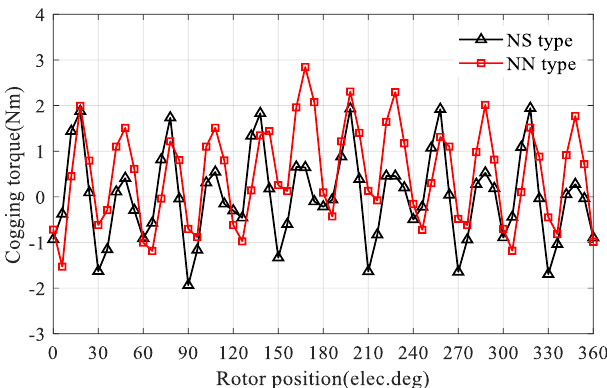
Figure 15. Comparison of cogging torques of AF-FMPM machine topologies.